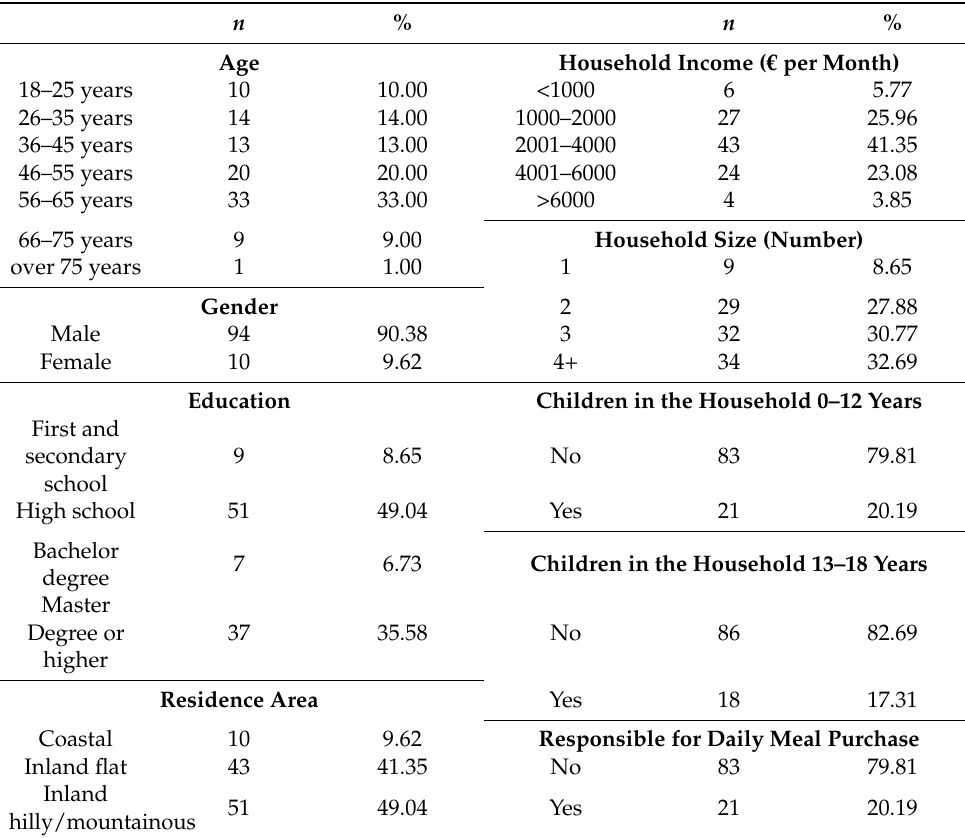
Table 1. Socio-demographic characteristics of the